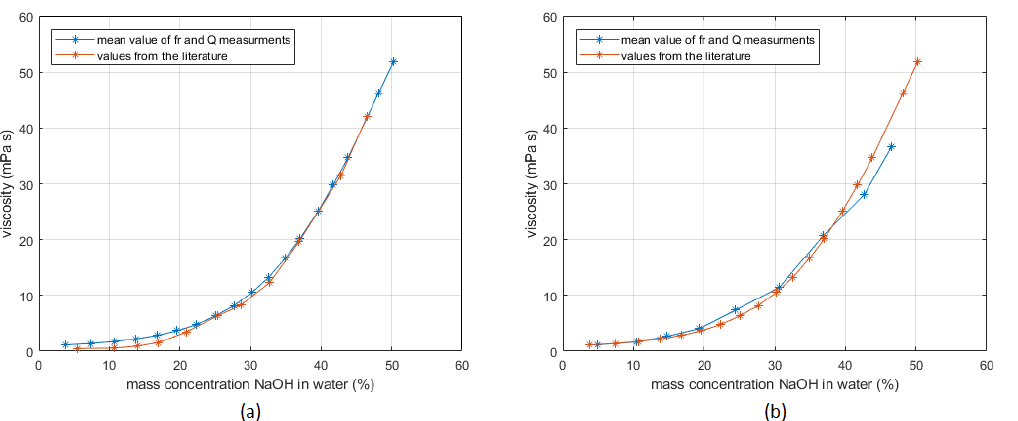
Figure 8. Measured viscosity at 25 ◦ C with (a) quartz with a planar surface (WTiAu0514, LapTech Precision Inc.) and (b) quartz with a convex surface (S-CAAAB-5MG03, Taitien Electronics Co., Ltd.) compared to values from the literature (Sipos et al.,